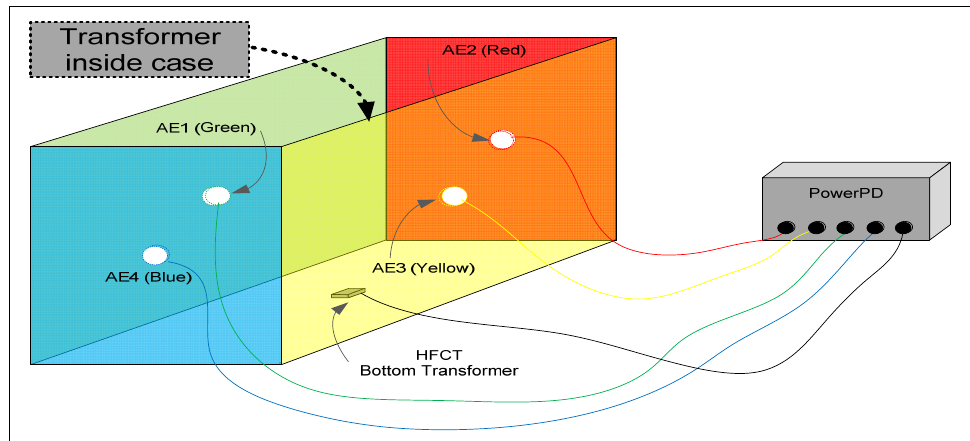
Figure 3. Schematic diagram of experimental